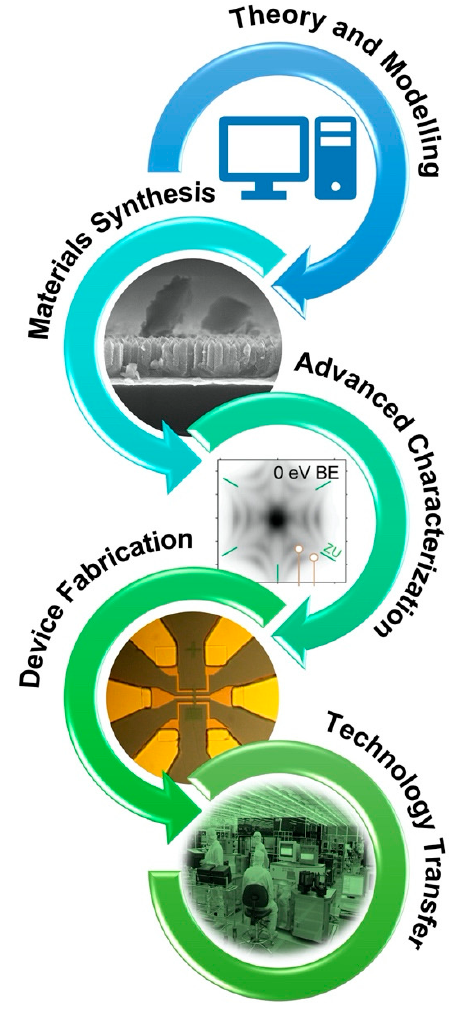
Figure 1. Workflow for a roadmap towards industrial exploitation of quantum materials.